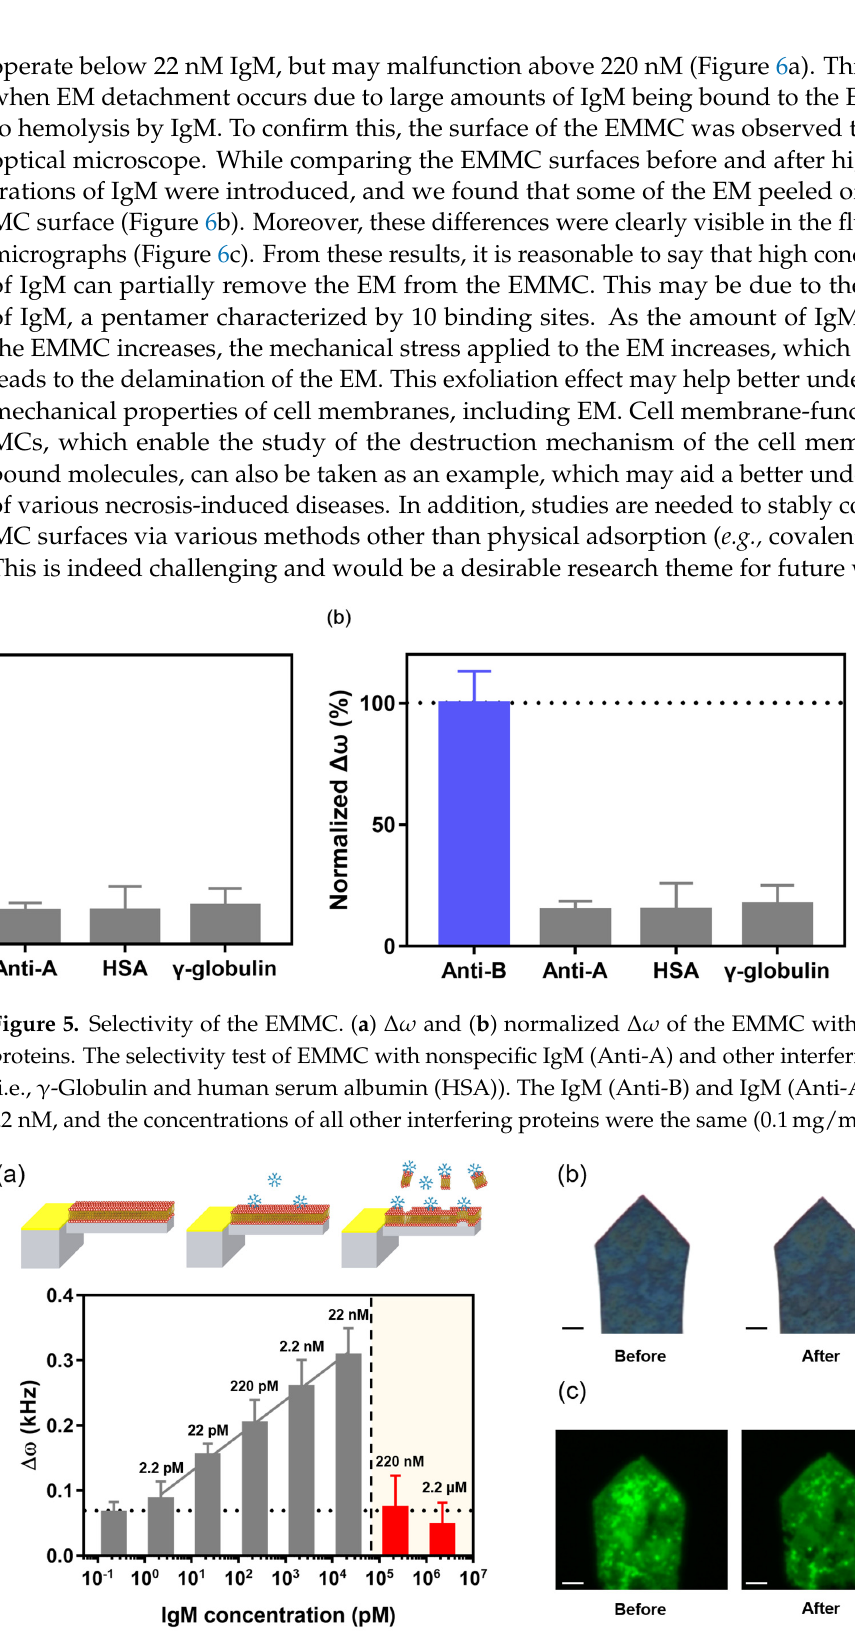
Figure 6. ( a ) Δ ω according to the low (2.2 pM–22 nM, gray) and high IgM concentration (220 nM–22 μ M, red). ( b ) Microscopic and ( c ) fluorescence images before and after high- concentration IgM (220 nM) binding with the EMMC. For each IgM concentration, a trip- licate measurement was performed. Scale bar, 10 μ